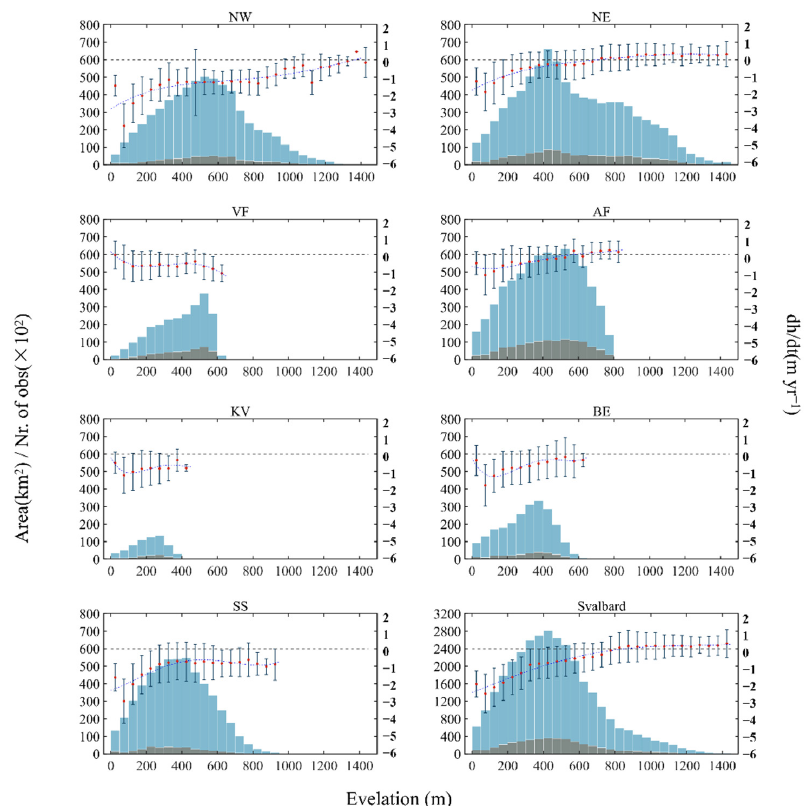
Figure 2. ( a ) Average glacier elevation change rates ( dh / dt ) across the Svalbard archipelago in 2019 – 2021. ( b ) Mean elevation time series of Svalbard glaciers in 2019 – 2021. Blue bar is the mean eleva- tion, red dashed line is the trend line.